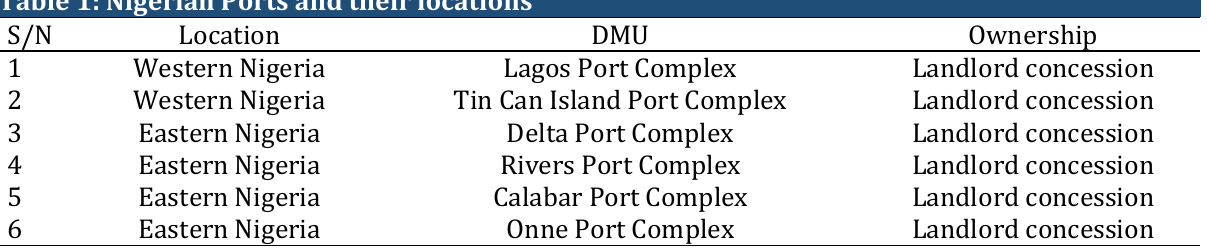
Table 1: Nigerian Ports and their locations S/N